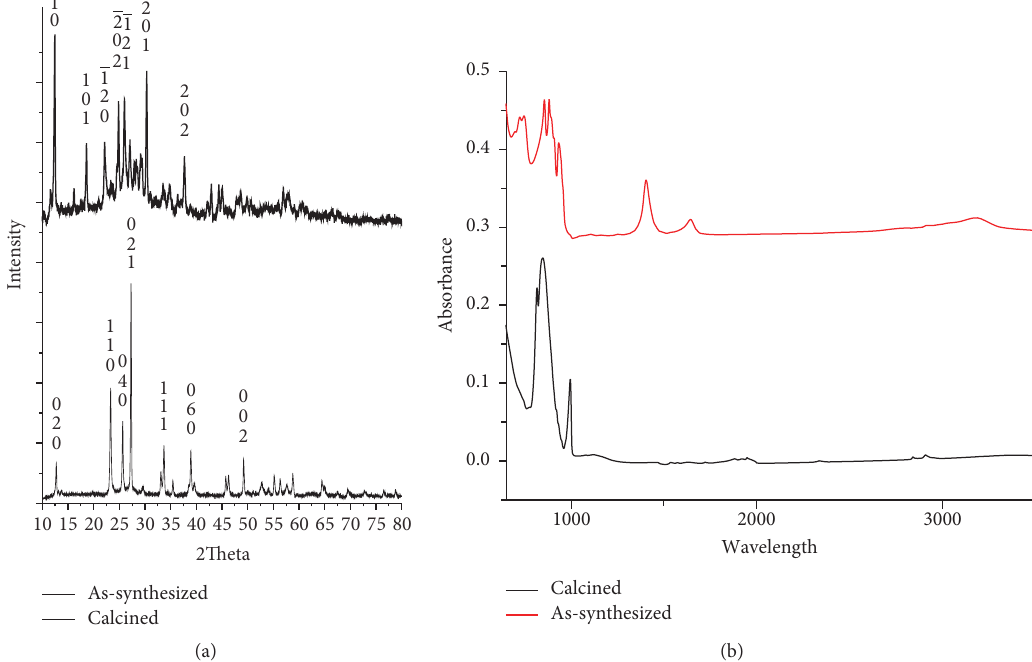
Figure 1: (a) XRD pattern on as-synthesized and calcined MoO 3 powders. (b) FTIR pattern on as-synthesized and calcined MoO 3